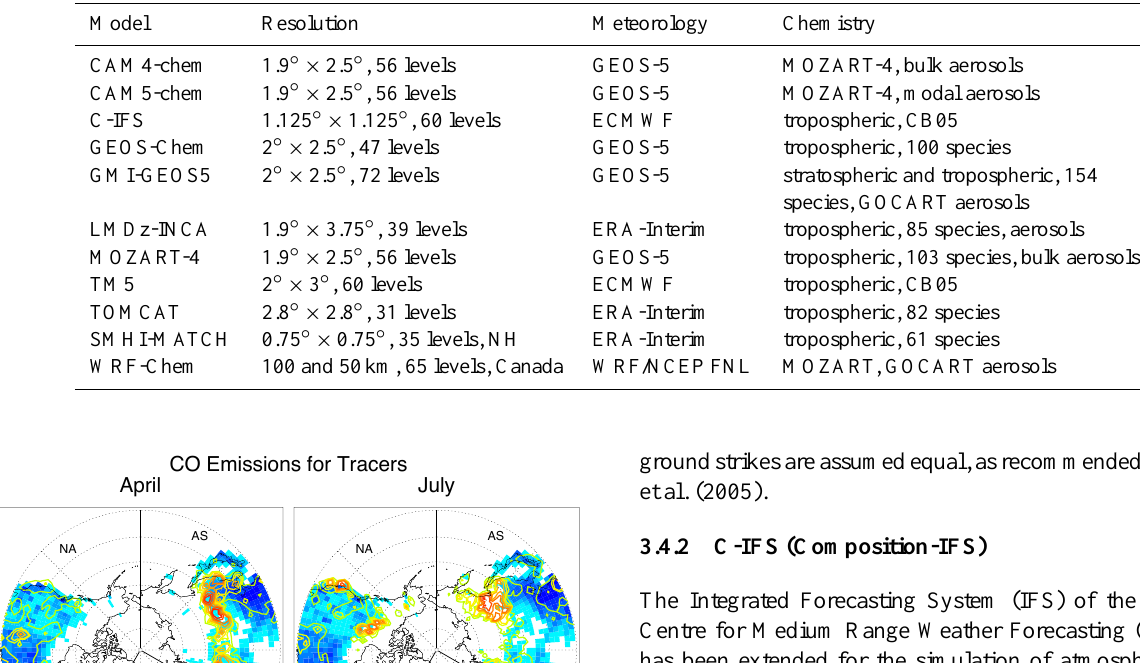
Table 3. Summary of POLMIP models.